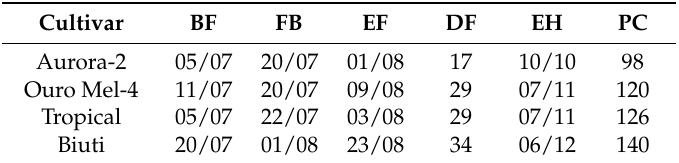
Table 1. Gathering of phenological stages: beginning of flowering (BF), full bloom (FB), end of flowering (EF), duration of flowering (DF), expressed in days, end of harvest (EH), and the productive cycle (PC), expressed in days, from peach cultivars Aurora-2, Ouro Mel-2, Tropical and Biuti in 2016. Federal University of Lavras, Lavras, MG, Brazil, 2016.